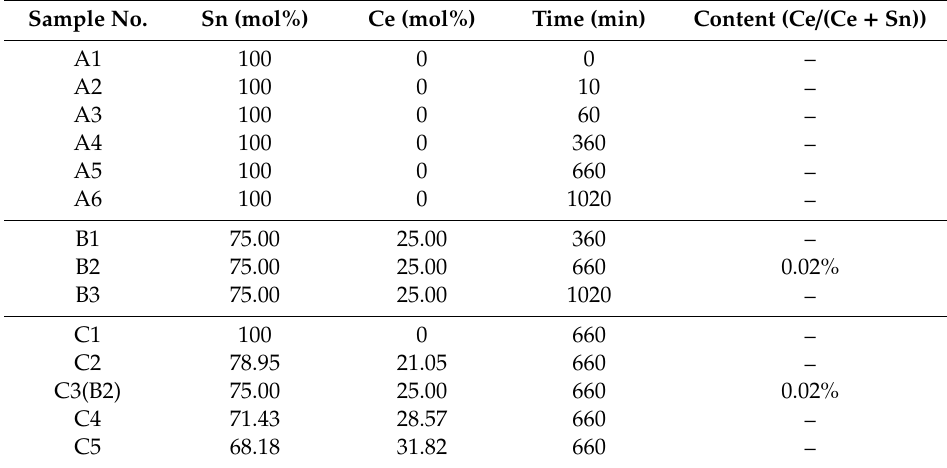
Table 1. The synthesis condition and inductively coupled plasma (ICP) data of the samples. Sample